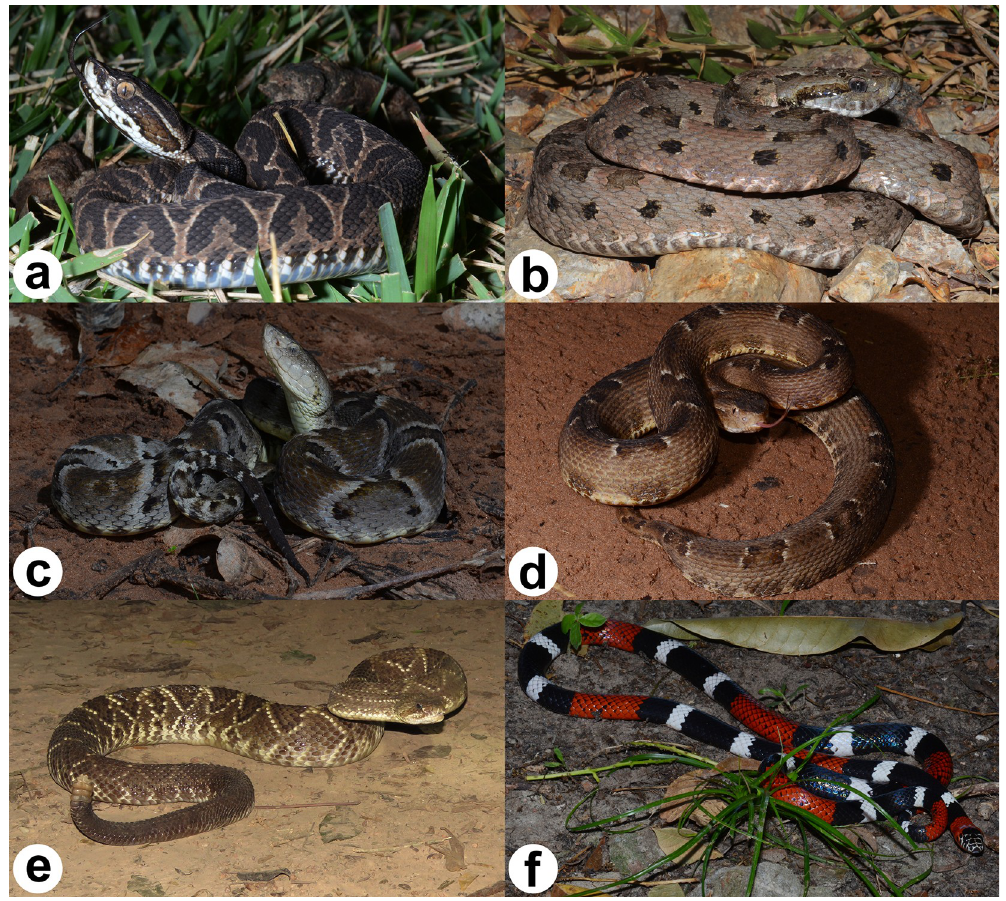
Fig 3. Common venomous snakes from Mato Grosso do Sul state (Brazil), where: a) Bothrops alternatus (cruzeira), b) Bothrops mattogrossensis (boca-de-sapo), c) Bothrops moojeni (jararaca), d) Bothrops pauloensis (jararaca-pintada), e) Crotalus durissus (cascavel) and, f) Micrurus tricolor (coral). All photos are from Diego J. Santana, author of the manuscript.